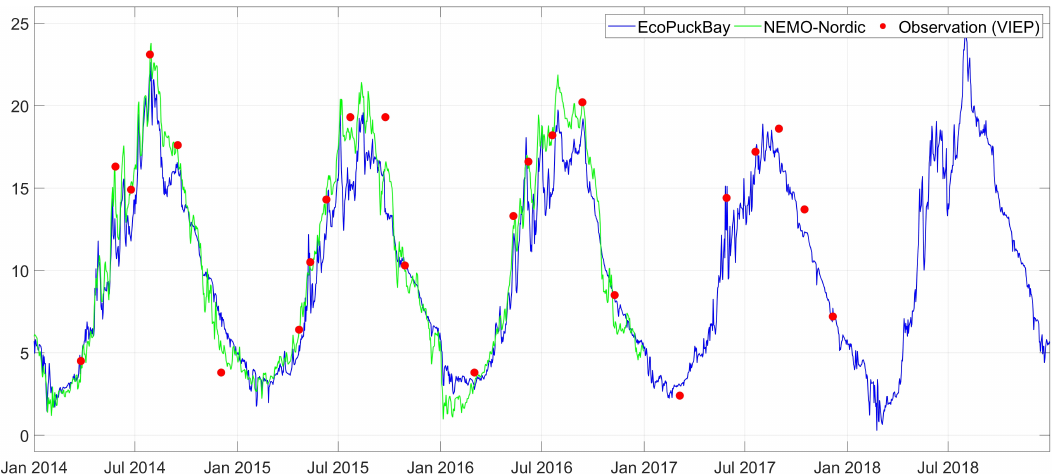
Figure A6. Time series of surface water temperature on station ZG compared with VIEP observations and NEMO-Nordic